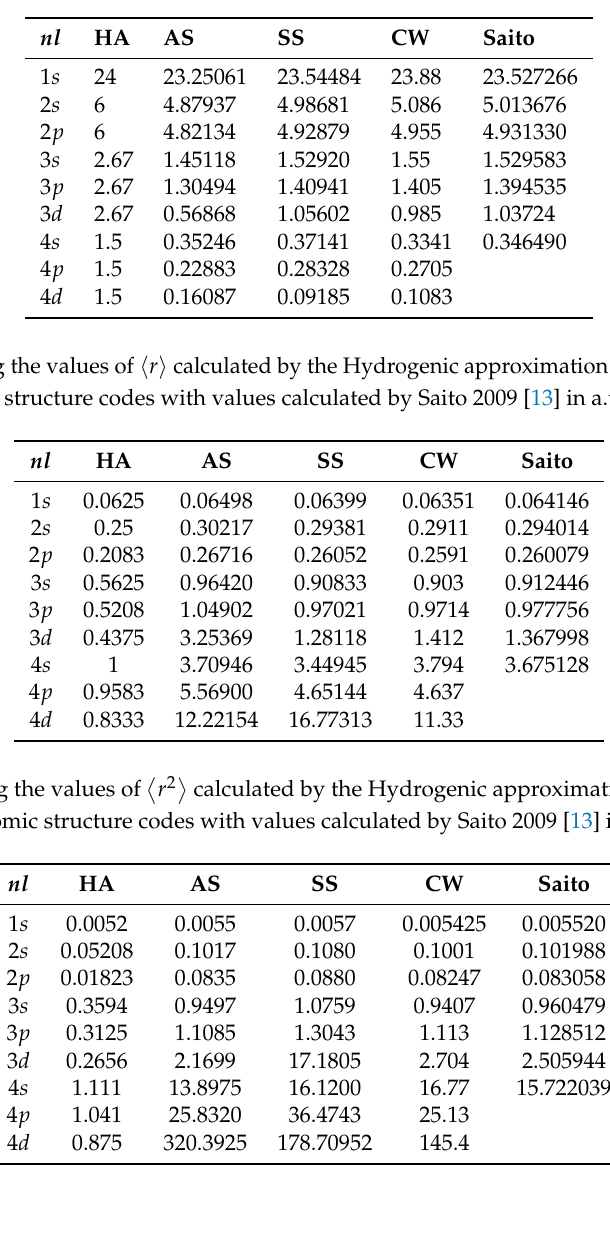
Table 2. Comparing the values of